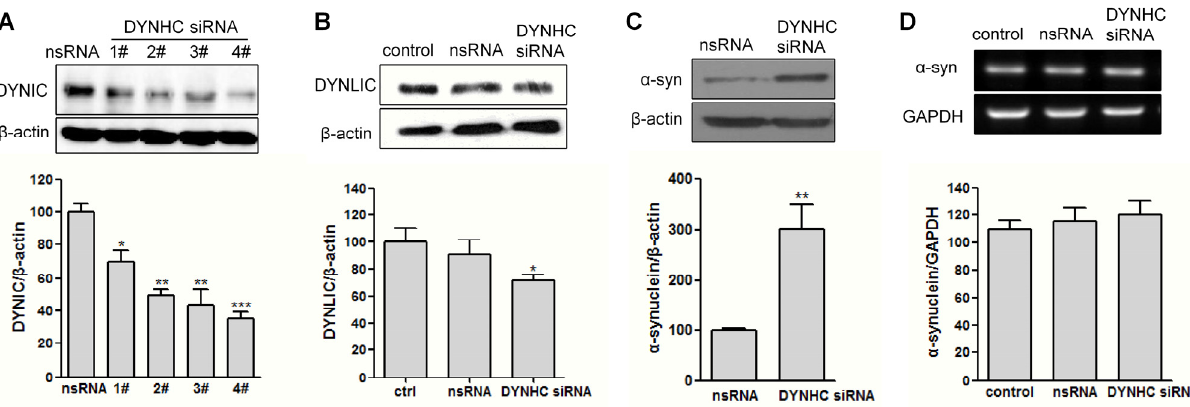
), the time for 1/2